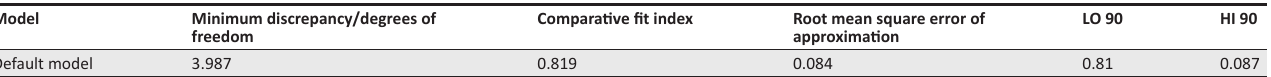
TABLE 4: Goodness-of-fit indices.